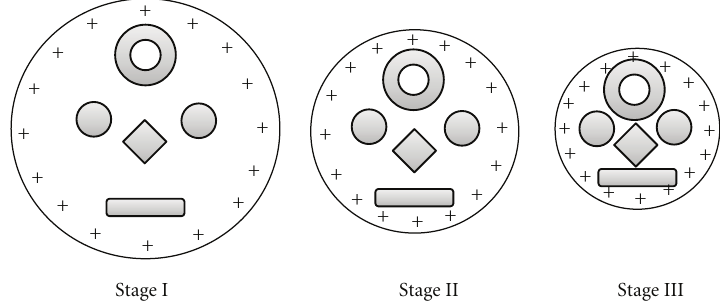
Figure 9: Hypothetical picture of a charge droplet containing five analytes of di ff erent shapes and sizes at three di ff erent stages of the solvent evaporation before Coulomb